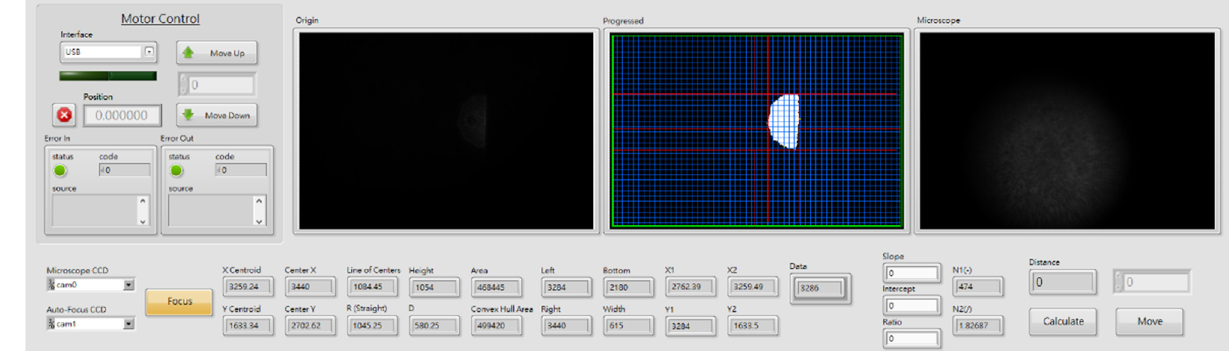
Figure 5. Proposed HMI.